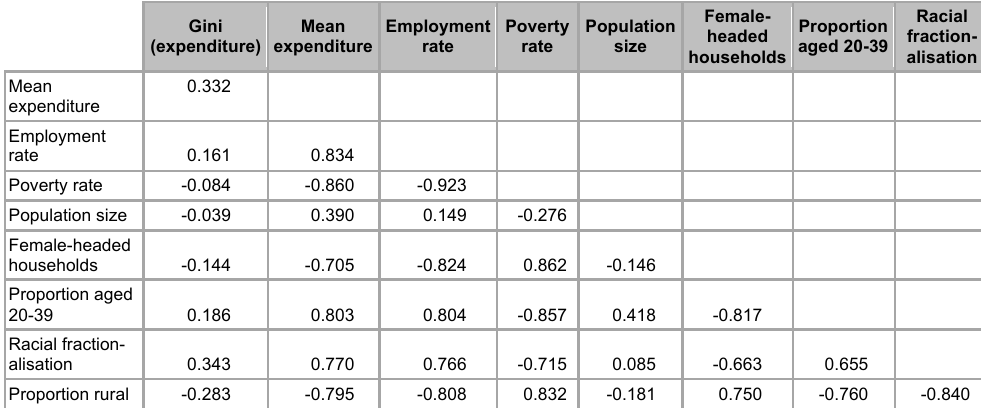
Table A1: Correlations amongst independent